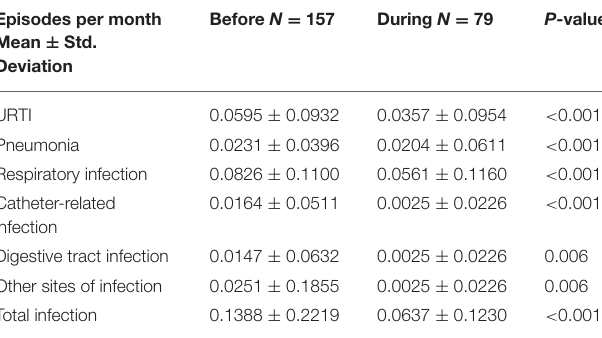
TABLE 4 | Historical paired comparison on infectious episodes before and during the COVID-19 pandemic. Episodes per month Mean ± Std.